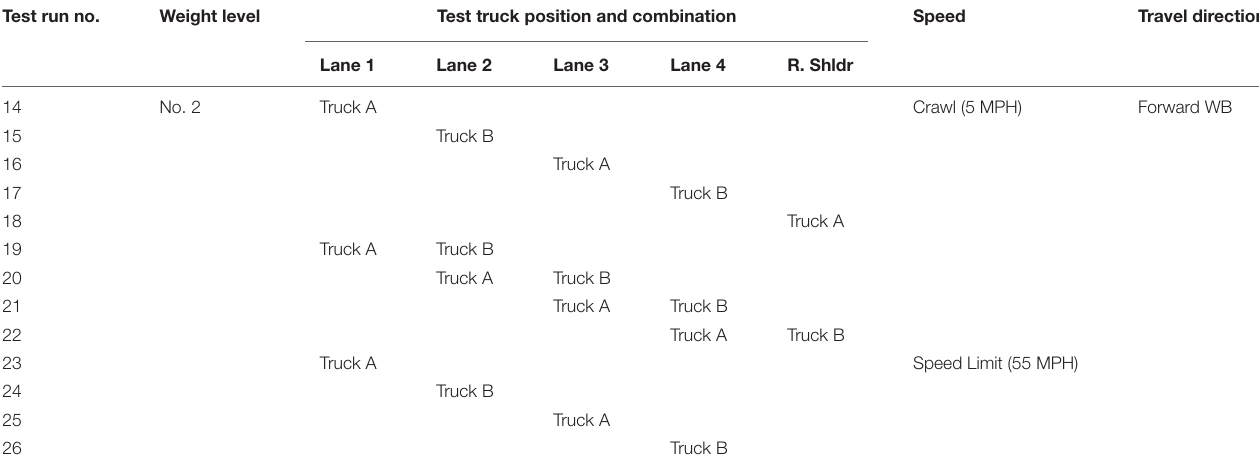
(Top) are the average of four strain sensors on both webs of Girders B and C; the red dashed lines in Figure 10 (Bottom)